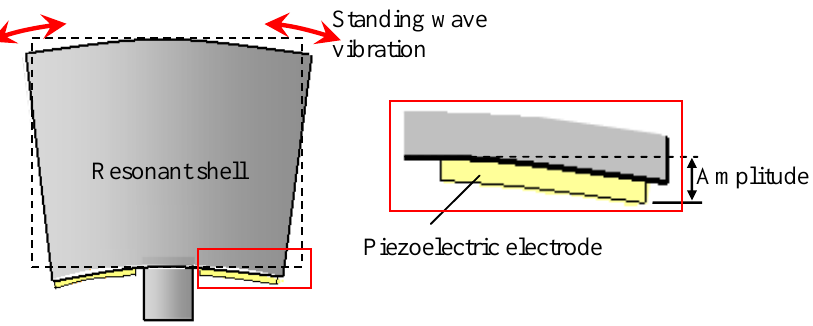
Figure 7. The block diagram of the control method and a photo of the control